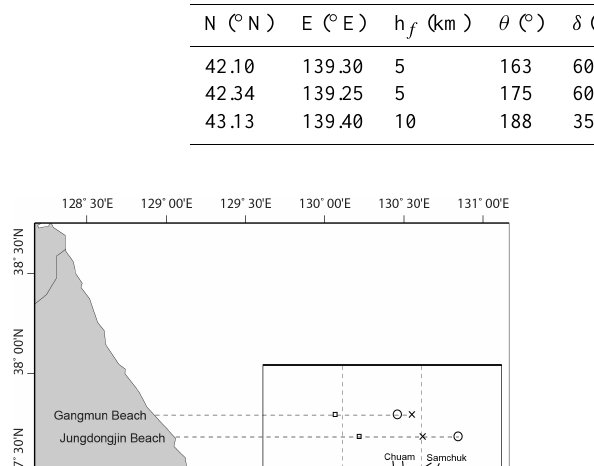
Table 1. Fault parameters of the 1993 Hokkaido earthquake.